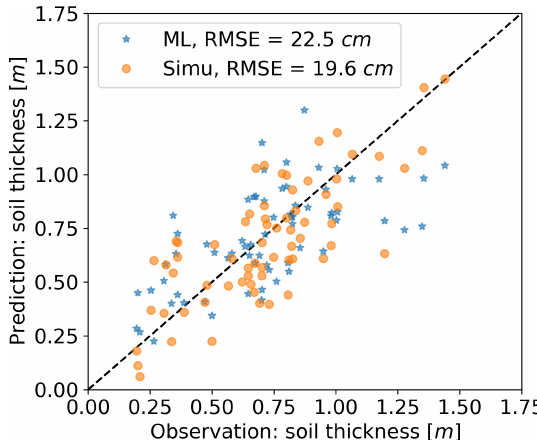
Figure 6. Comparison between observed and predicted soil thick- ness. Note that ML indicates a machine-learning-based simulation, Simu indicates the hybrid model simulation, and RMSE stands for root-mean-square error.